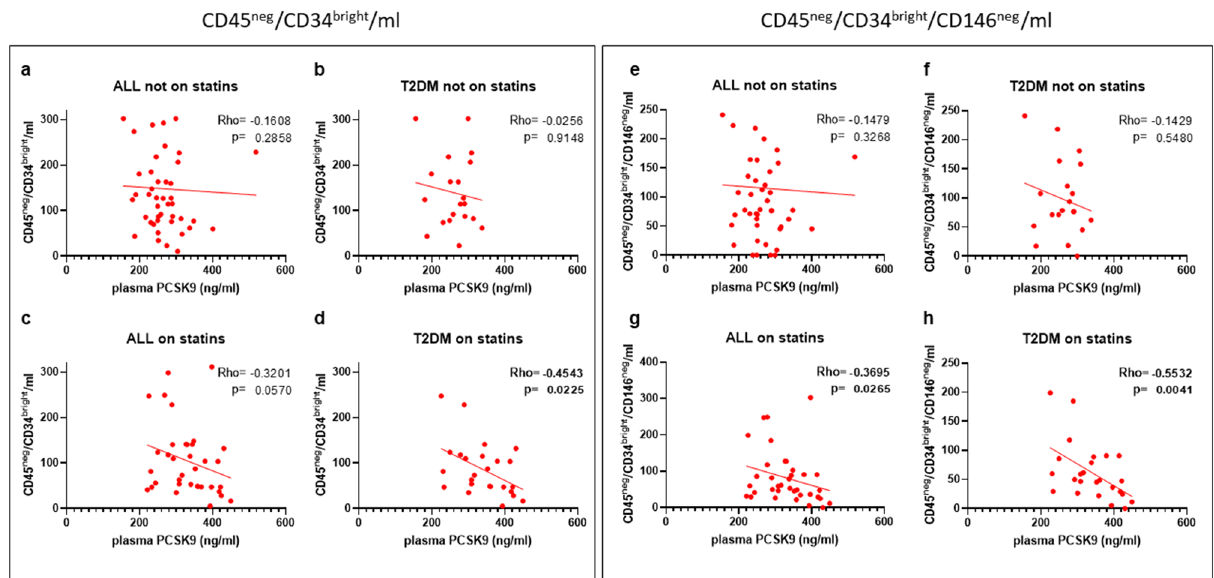
Figure 4. Plasma PCSK9, EPCs and statin treatment . Correlations between levels of plasma PCSK9 and number of CD45 neg /CD34 bright ( a – d ) and CD45 neg /CD34 bright /CD146 neg ( e – h ) in patients considered as a whole not on statins ( a , e ) and on statins ( c , g ) and in T2DM patients not on statins ( b , f ) and on statins ( d , h